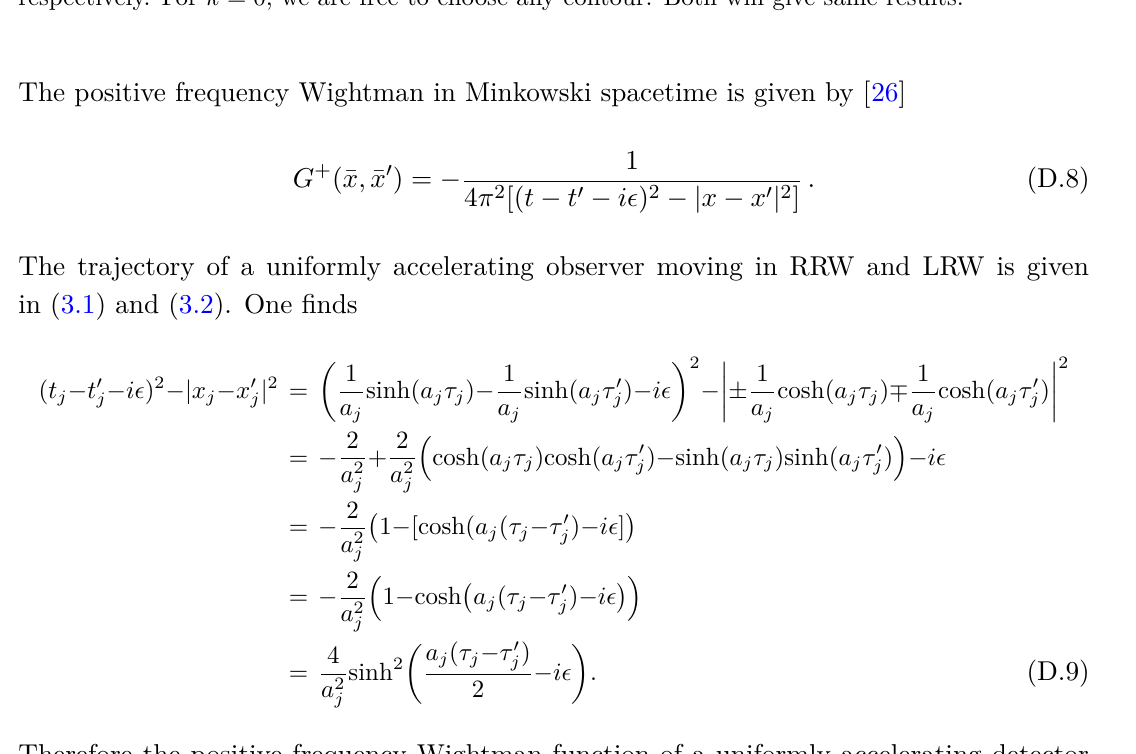
Figure 11. Plots showing contours of integral T . For an integrand like f ( T ) = e ± ikT / [( T 2 − )( T 2 − T 2 )] , we choose upper and lower contours for positive and negative sign of the exponential, T 2 1 2 respectively. For k = 0 , we are free to choose any contour. Both will give same